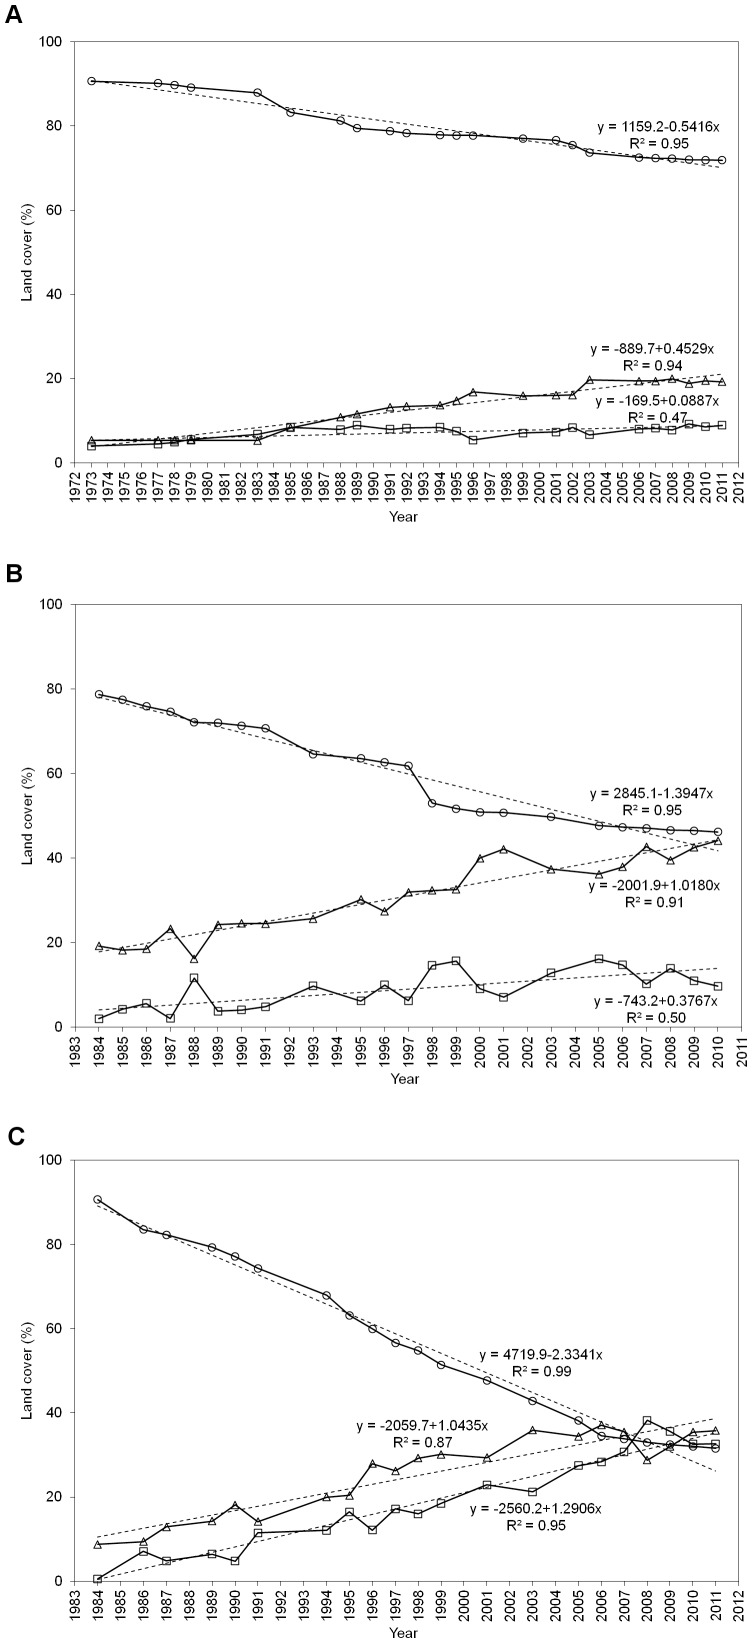
Land cover change (%) across the three selected sites.Land cover change (%) across the three selected sites; A) Manaus (1973–2011), B) Santarém (1984–2010), and C) Machadinho d’Oeste (1984–2011). Each dashed line represent the linear fit of the proportion of each land cover class as a function of the year; also showing are the corresponding equations and coefficient of determination (R2).(○ - mature forest, □ - non-forest, Δ- secondary forest).